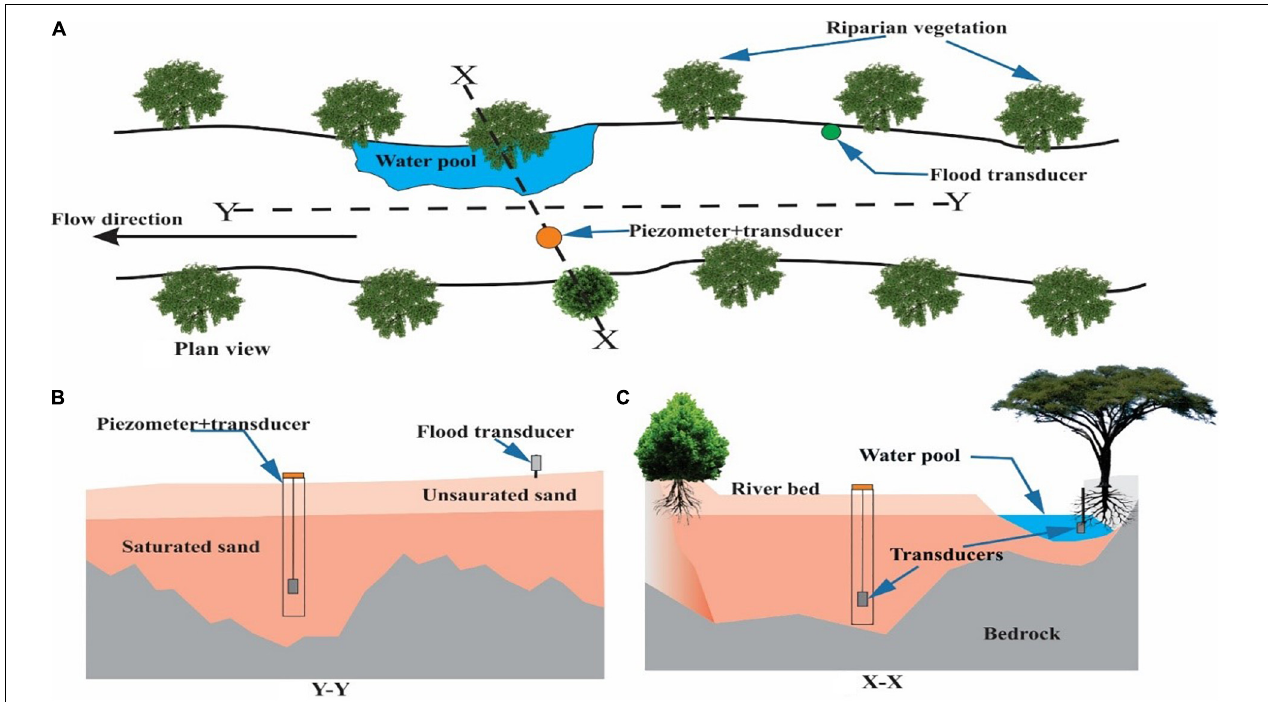
FIGURE 3 | Schematic representation of groundwater, surface flow, and water pools monitoring transducer installations in the upstream of the Sand River sub-catchment between November and December, 2016. (A) Plan view, (B) Longitudinal (Y-Y) section and (C) Transverse